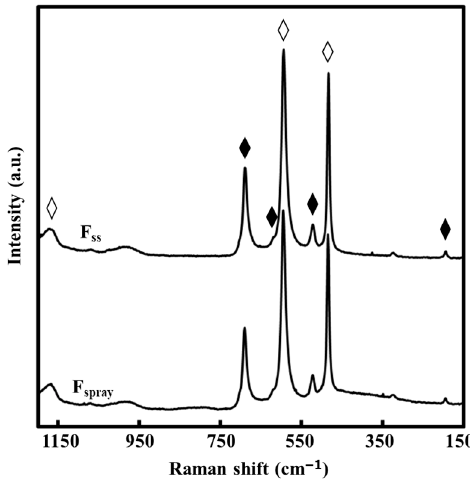
Figure 3. Raman spectra of F spray and F ss . Peaks assignable to the vibration modes for LCO and Co 3 O 4 are represented by ♢ and ♦ , respectively.